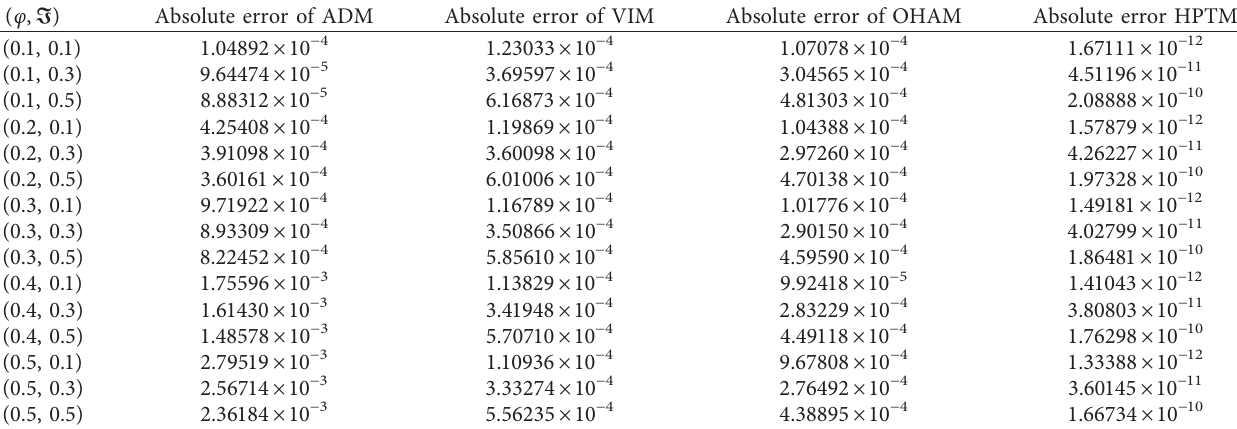
Table 3: HPTM for the approximate solution of Example 1.